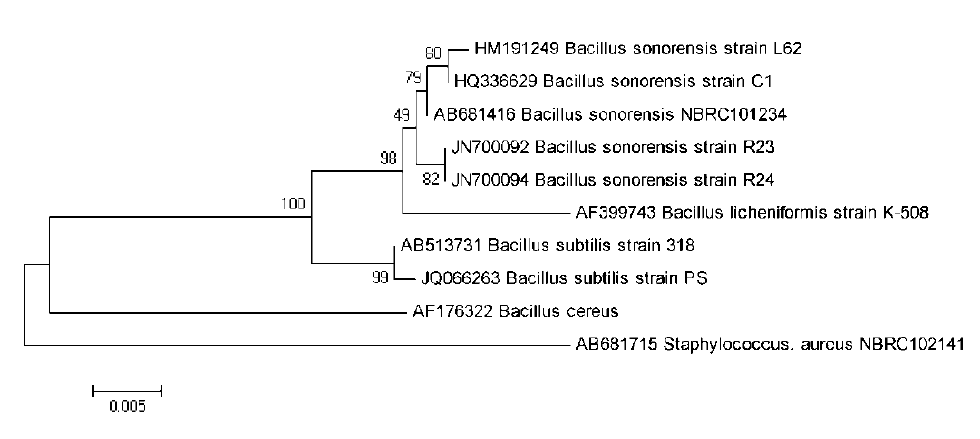
Figure 2. Phylogenetic analysis of the 16S rDNA gene of L62. Bootstrap values (expressed as percentages of 1,000 replications) are shown at branch points. Bar represents evolutionary distances as 0.005 changes per nucleotide position. Staphylococcus aureus NBRC102141 served as outgroup. GenBank accession numbers are shown on the left of species names.